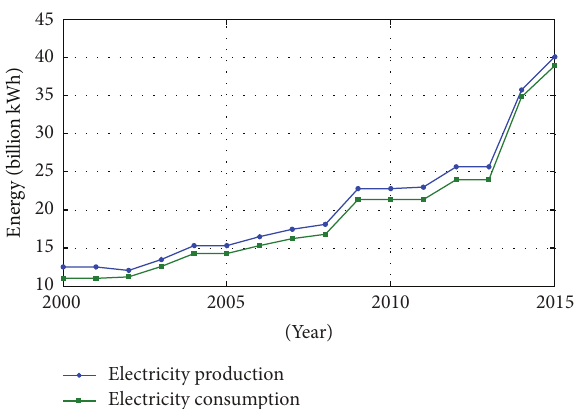
Figure 3: Energy generation and consumption over different years.